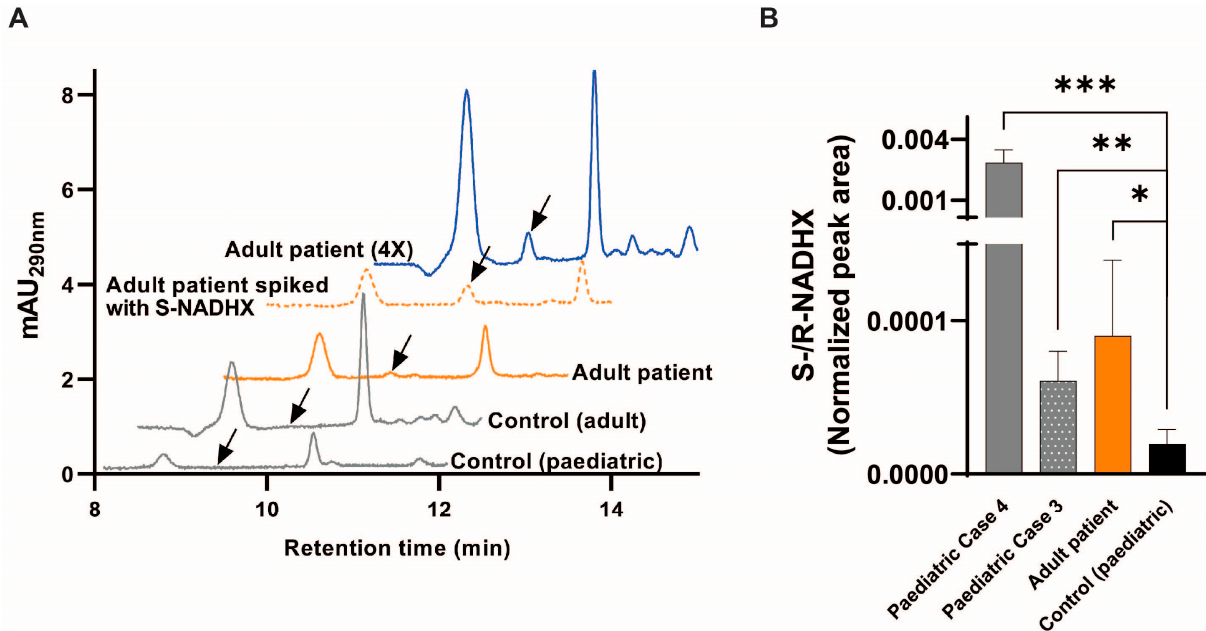
Figure 4. Fibroblast metabolic analysis of the proband with the NAXD c.441+3A>G variant. ( A ) HPLC-UV analysis of fibroblasts grown under standard cultivation conditions shows the presence of the damaged metabolite S-NADHX in the adult patient fibroblasts but not in adult or paediatric control lines. Chromatograms from a representative experiment are shown with the black arrows indicating the peak eluting at the retention time of standard S-NADHX. The orange dotted trace was obtained by analysis of the adult patient fibroblast extract spiked with 2 µ M standard S-NADHX. The blue trace, indicated as adult patient (4X), was obtained by analysis of an adult patient fibroblast extract derived from an experiment in which cultures were launched by seeding four times more cells as in our standard protocol (1 × 10 6 cells instead of 2.5 × 10 5 cells). ( B ) ICMS analysis of fibroblasts cultured under galactose stress also showed increased S/R-NADHX levels in patient cells compared to control cells. Cyclic-NADHX forms were also detected at higher levels in patient fibroblasts (Supplementary Figure S6). Peak areas were normalised to internal standard (IS) areas. All values are means ± SD of four independent replicates. Statistical significance was calculated using an equal variance, unpaired Student’s t -test. * p < 0.05, ** p < 0.01, *** p <